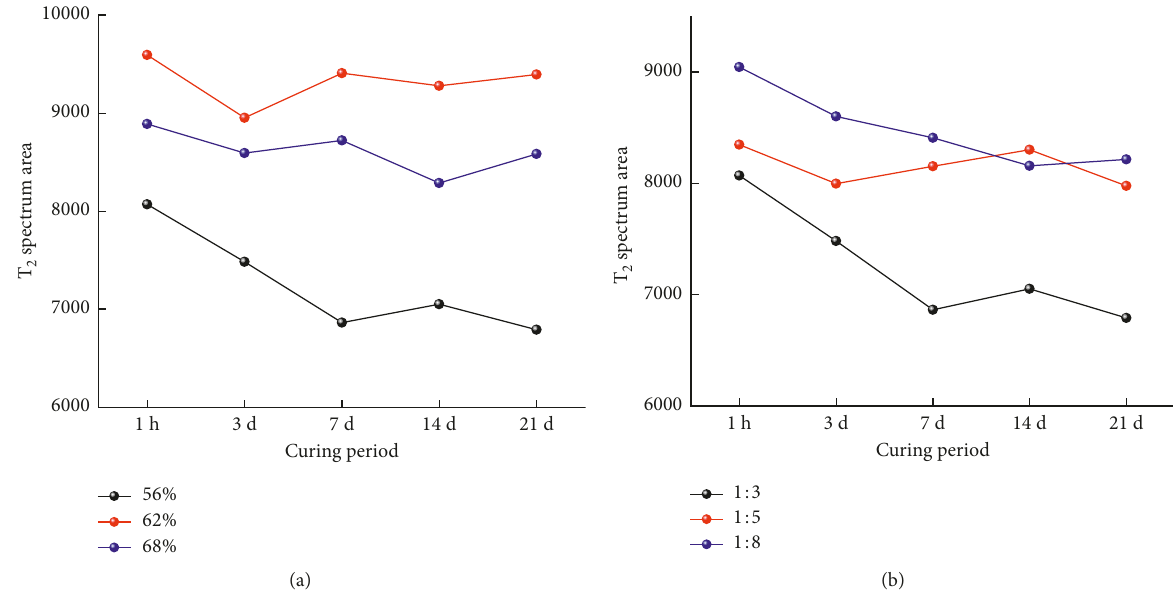
Figure 8: (a) The T 2 spectrum area of three kinds of filling slurries with different concentrations and curing periods. (b) The T 2 spectrum area of three kinds of filling slurries with different cement-sand ratios and curing